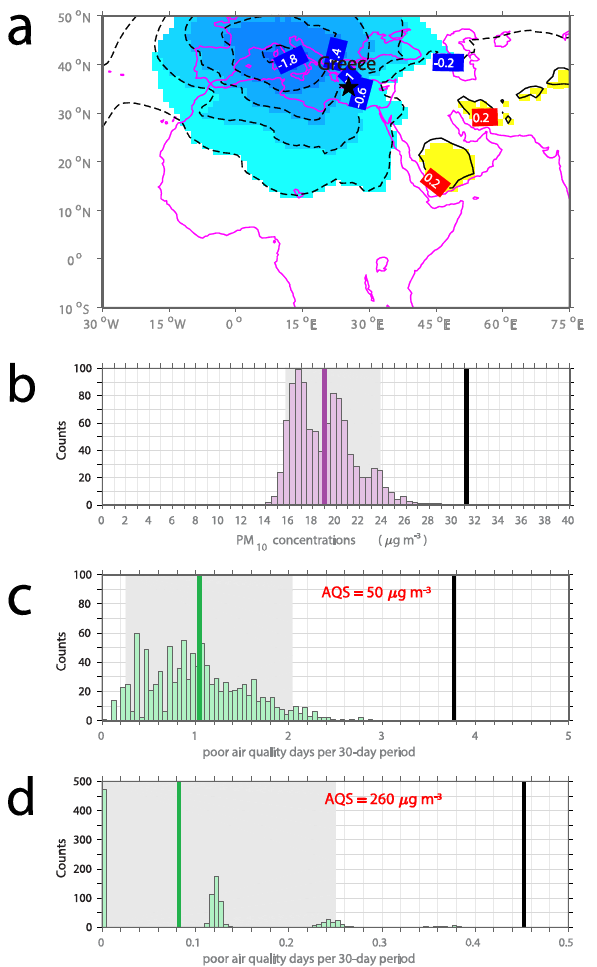
Fig. 4 | Observedair qualityresponse to suddenstratosphericwarming events (SSWs). a Regression of anomalous sea level pressure (SLP) (from the MERRA2 reanalysis) onto the station measurements of daily time-series of surface inhalable particulate (PM 10 )concentrationsfrom Finokalia,Greece. Warm and coldshadings indicate positive and negative anomalies that are statistically signi fi cant at the p <0.10 level based on a Student ’ s t -test, respectively. Histogram of b the level of PM 10 concentrations (units: μ g m − 3 ) at Finokalia, Greece and c , d the expected number of poor air quality days per 30-day period for two air quality standards